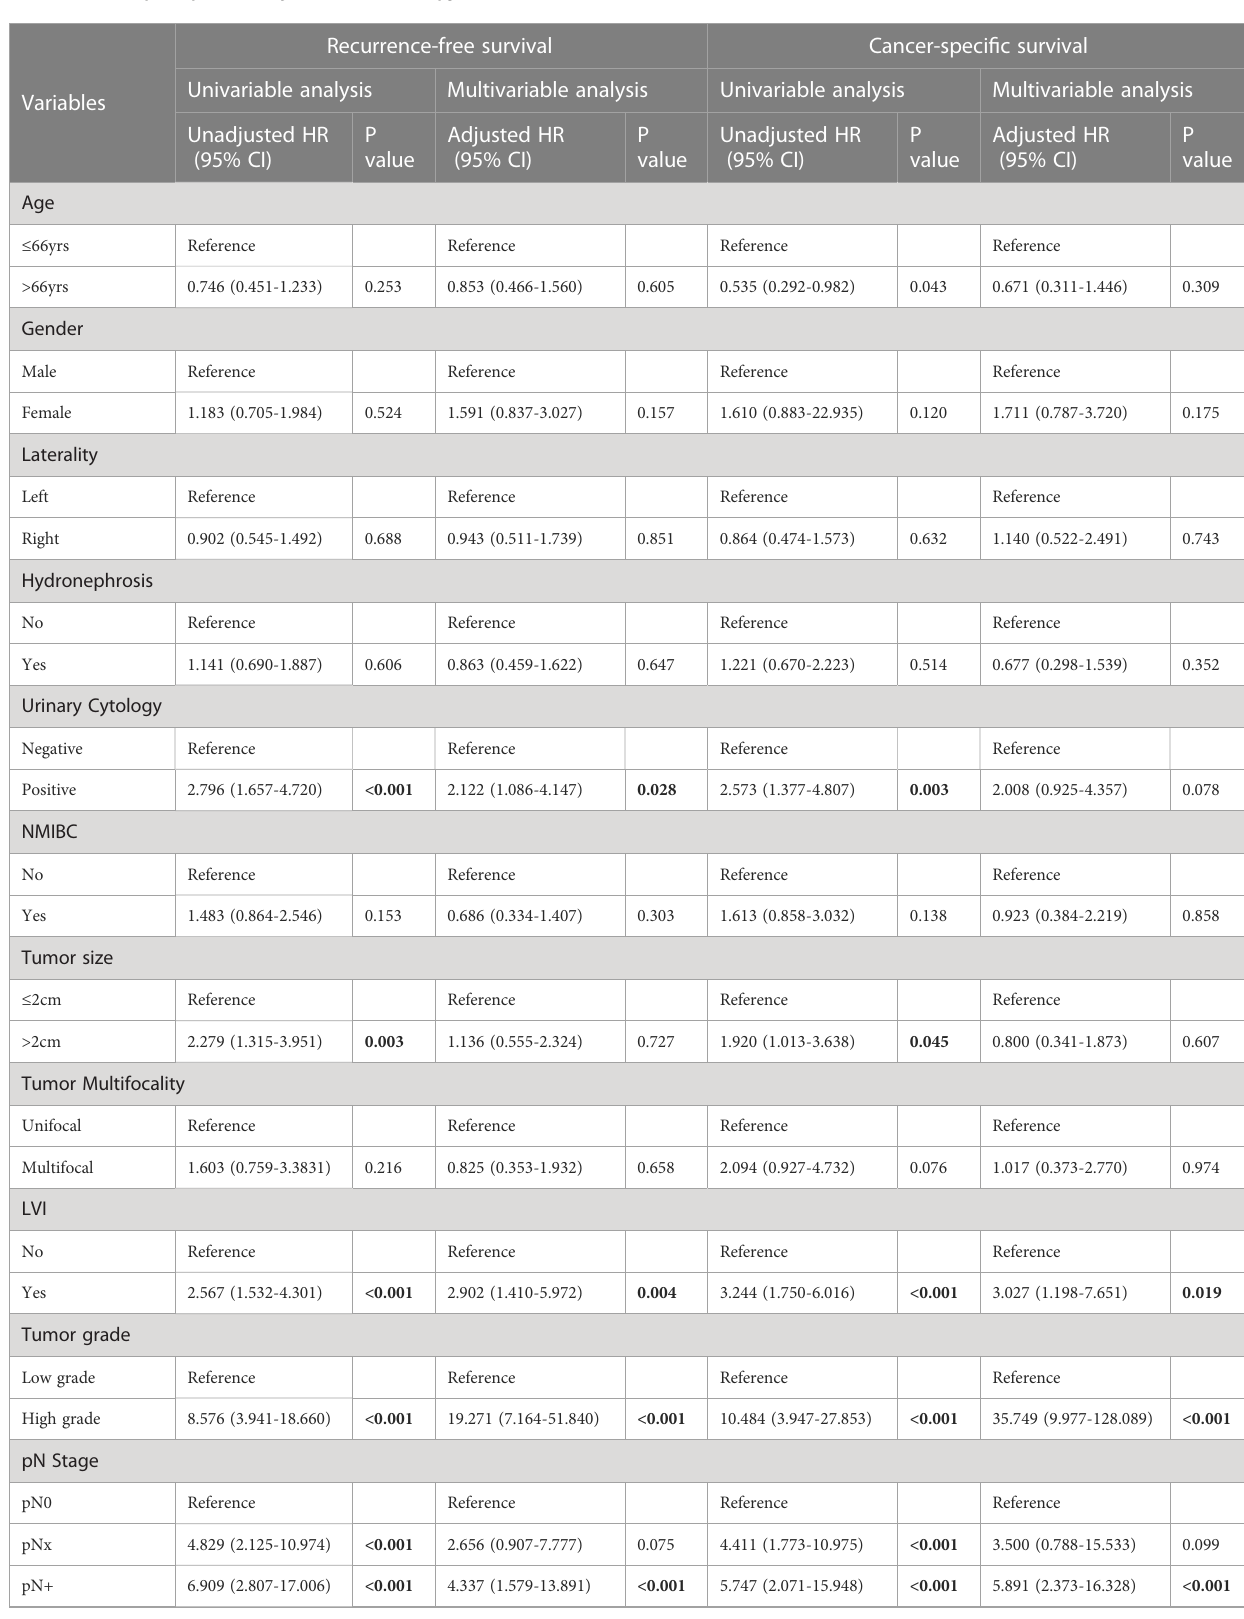
TABLE 4 Univariable and multivariable Cox proportional hazard models predicting recurrence-free survival and cancer-speci fi c survival in patients who underwent postoperative adjuvant